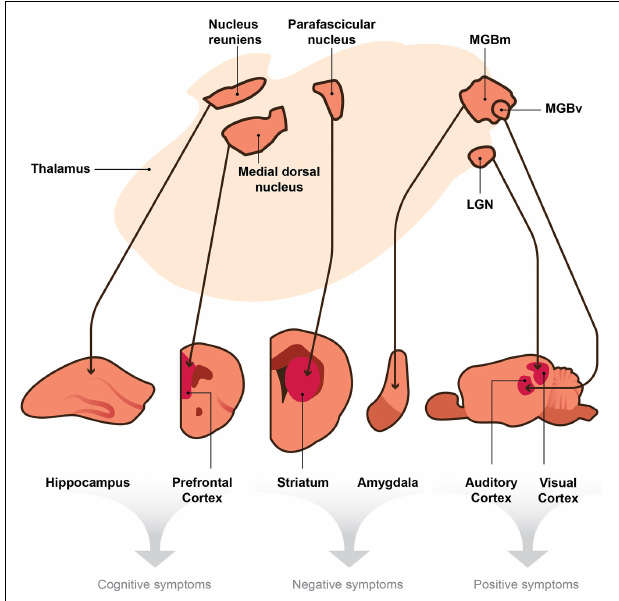
FIGURE 1 | A model depicting the hypothesis that the thalamus is a central node within the brain that sends divergent projections to multiple targets involved in the generation of distinct behaviors. Thalamic nuclei project to cortical and subcortical efferent brain regions. We posit that thalamic disruptions, which in turn lead to deficits in signaling between the thalamo-effector pathways (thin arrows), cause the seemingly unrelated symptoms of schizophrenia. According to this hypothesis, disruptions in signaling or oscillatory activity between the nucleus reuniens and hippocampus and those between the medial dorsal nucleus and the prefrontal cortex could generate cognitive symptoms of schizophrenia (e.g., deficits in attention and working memory). Disruptions within the parafascicular nucleus or in its projections to the striatum and those in the medial division of the medial geniculate body (MGBm) and its projections to the amygdala may cause negative symptoms (e.g., avolition or blunted affect). Finally, aberrant signaling from the ventral region of the medial geniculate body (MGBv) to the auditory cortex and that from the lateral geniculate nucleus (LGN) to the visual cortex may produce positive symptoms of schizophrenia (e.g., auditory or visual hallucinations). Although the collateral projections of the TRN may play a role in these mechanisms, they are not included in this diagram for